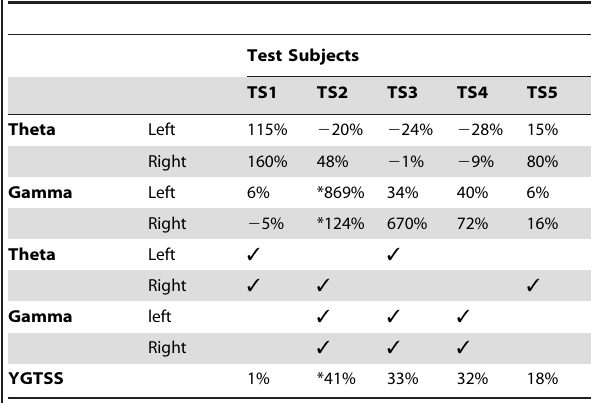
Table 2. Changes in theta, gamma, and YGTSS over the six- month study.